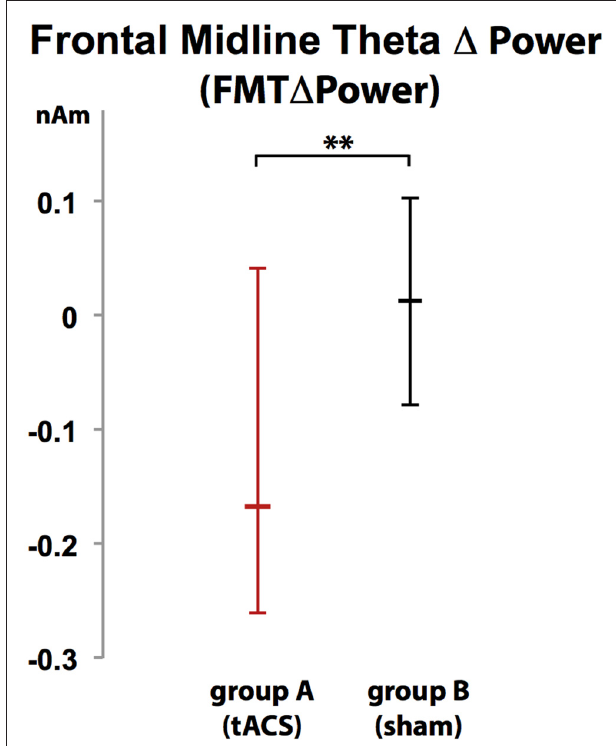
FIGURE 6 | Increase in FMT power (FMT ∆ power) during execution of a 2-back task was significantly different in group A (tACS) compared to B indicating that frontal theta tACS results in lack of FMT ∆ power shown to correlate with WM demand and performance. Error bars indicate 95% confidence intervals. ∗∗ p <